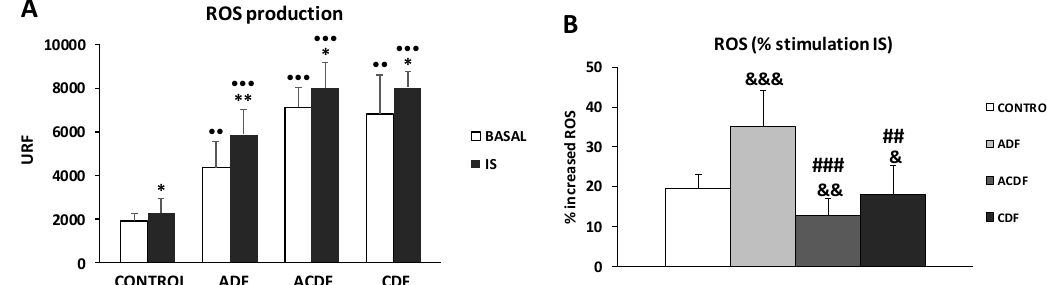
Figure 1. Intracellular reactive oxygen species (ROS) production under basal conditions and in response to indoxyl sulfate (IS, 256 µg/mL), in human THP-1 monocytes cultured in control solution (Hank’s medium) or in different dialysis fluids (ADF, 3 mM acetate; ACDF, 0.8 citrate + 0.3 mM acetate; CDF, 1 mM citrate). ( A ) ROS levels (URF) and ( B ) percentage (%) increase in ROS production by THP-1 cells after 180 min of stimulation with IS. Each column represents the mean ± SD of 5–8 independent experiments. * p < 0.05, ** p < 0.01, and *** p < 0.001 vs. the value in basal conditions. •• p < 0.01, and ••• p < 0.001 vs. the value in the control solution. ## p < 0.01 and ### p < 0.001 vs. the value ADF. & p < 0.05, && p < 0.01, and &&& p < 0.001 vs. the value of % of ROS in the control solution.